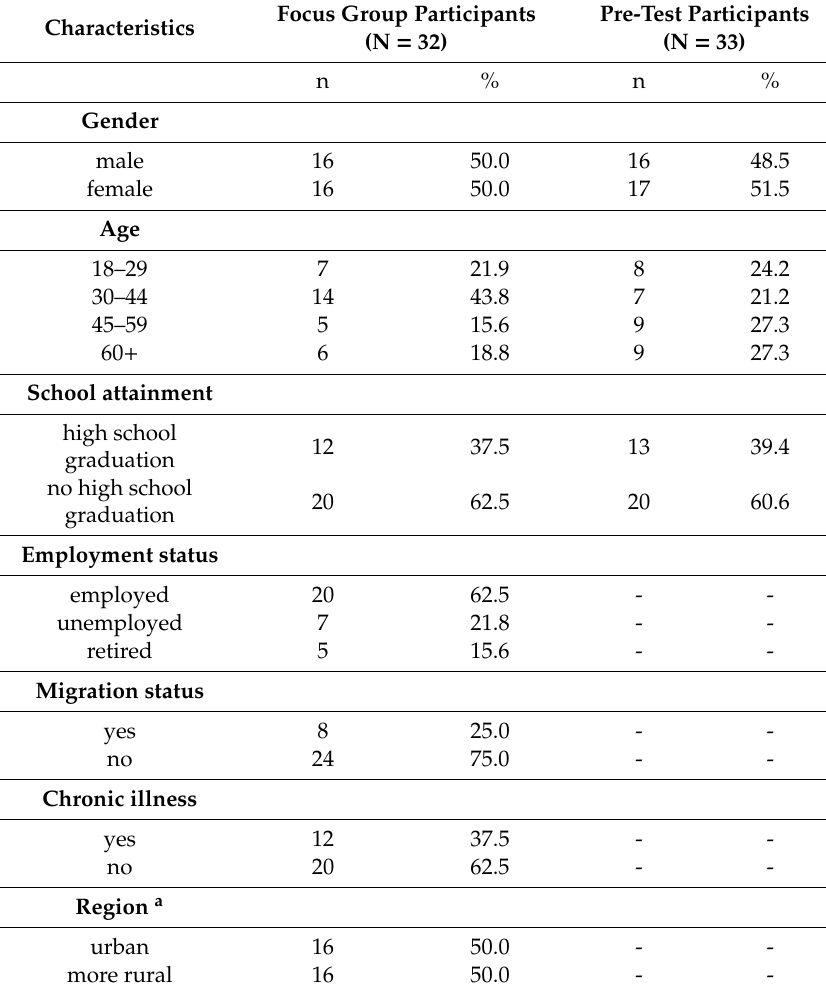
Table 2. Characteristics of focus group and pre-test